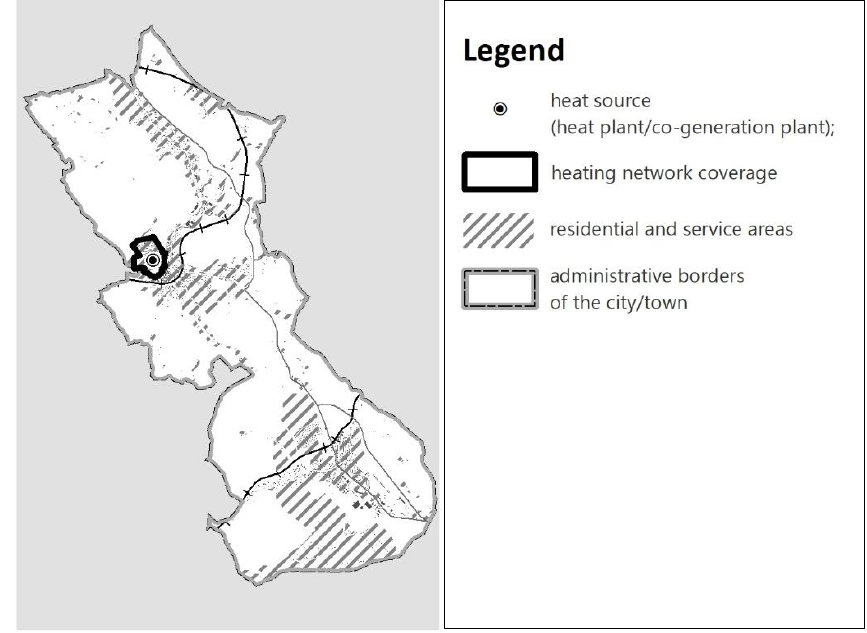
Figure 8. Areas intended for housing and service development, and the range of the district heat- ing network in Nowa Ruda. * HSAs—housing and service areas. network in Nowa Ruda. * HSAs—housing and service